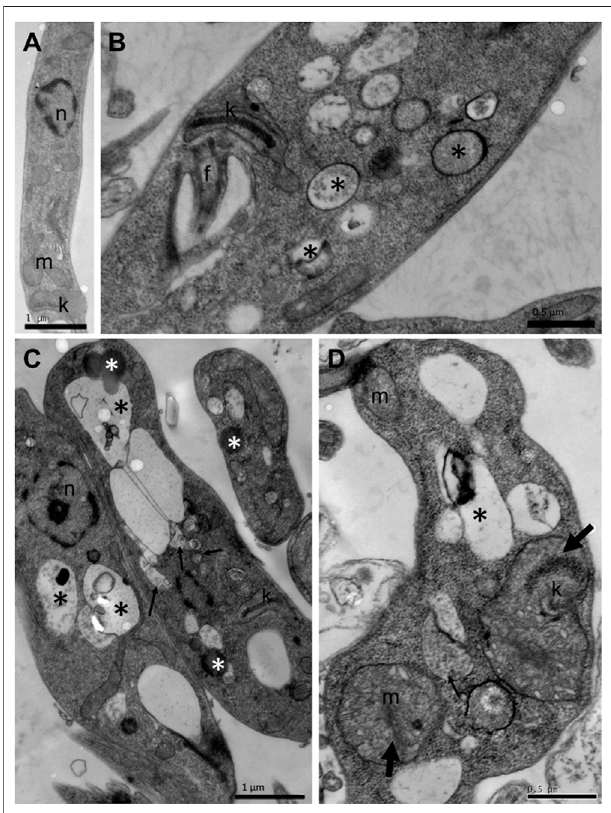
FIGURE 5 | Transmission electron microscopy of Leishmania amazonensis promastigote forms. (A) Untreated parasites. (B – D) Parasites were treated with Arrabidaea chica fl avone-rich fraction (ACFF) at 2.5 μ g/mL for 24 h. Several vacuoles containing granular, circular, and electron- dense material dispersed by the cytoplasm (black asterisks); lipid bodies; multivesicular bodies (thin arrows); swelling of kinetoplast and mitochondria with breakdown of mitochondrial cristae (thick arrow). n: nucleus; m: mitochondria; k: kinetoplast; f: fl